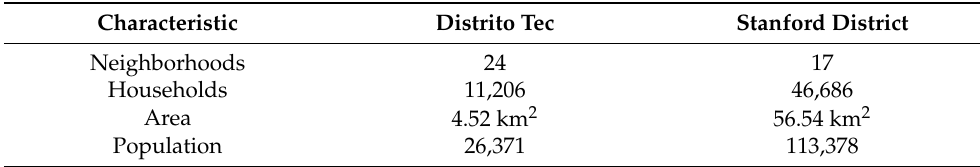
Figure 6. Delimitation of the Stanford District area within the San Francisco Bay Area, CA, USA. Stanford campus, parks, main roads, water bodies, and urban blocks are also shown. Table 1. Essential characteristics of the two study